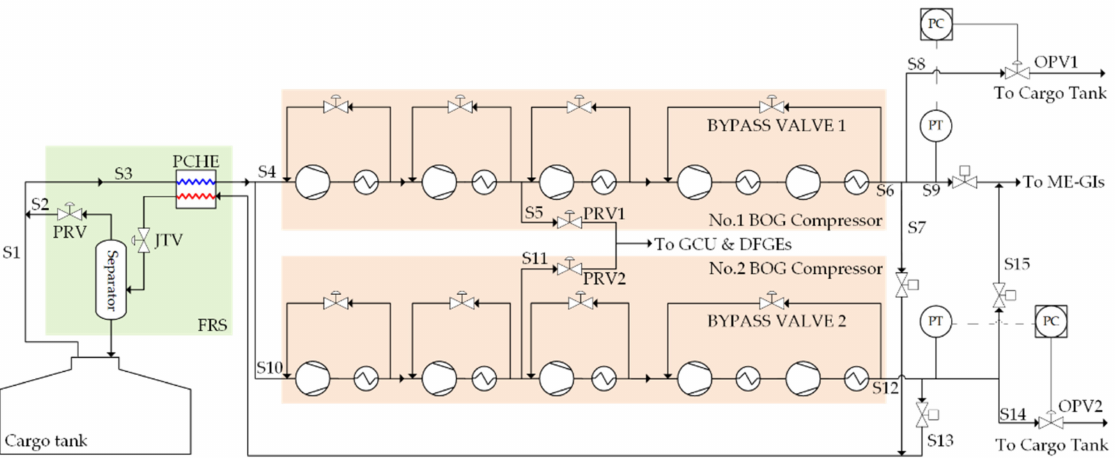
Figure 2. Configuration of a typical fuel gas supply system with a full re-liquefaction system (Case A).